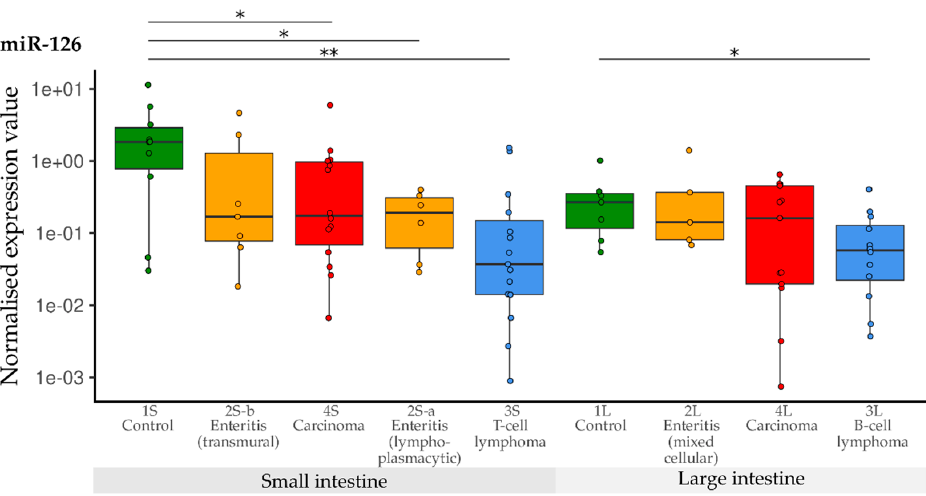
Figure 9. Expression levels of miR-126 in different groups (control, enteritis, carcinomas, lymphomas of the small and large intestine). The absolute miRNA copy number was related to the internal normaliser RNU6B. Results are shown as normalised expression values with a log10 scale. * p < 0.05, ** p < 0.005. Green control group, yellow enteritis, red carcinoma, blue lymphoma Compared with the controls, down-regulation of miR-214 was observed in the T-cell